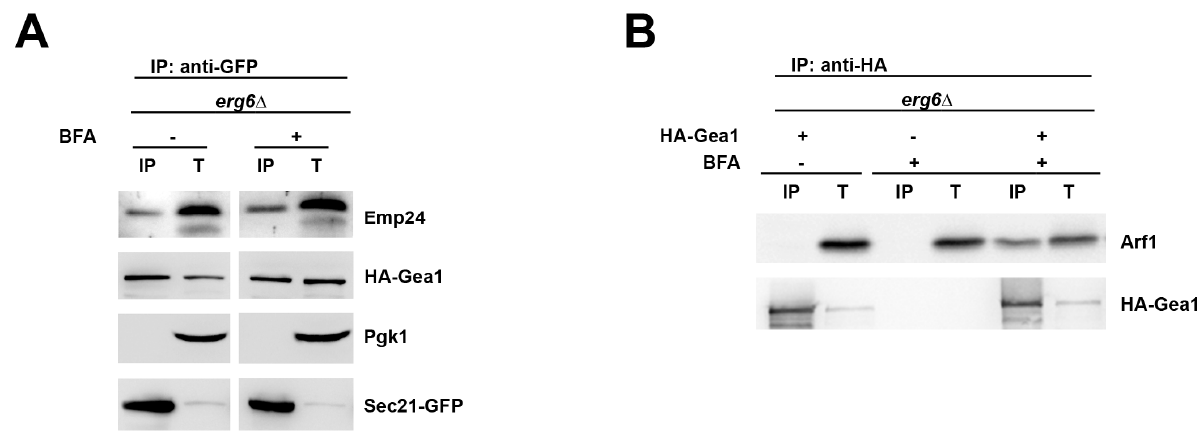
Figure 5. The p24 complex can interact with COPI independently of Arf1 activation. ( A ) erg6 ∆ mutant cells expressing HA-Gea1 and the COPI coat subunit Sec21-GFP were incubated with or without 100 µg/mL BFA (Brefeldin A) for 20 min. erg6 ∆ mutation was used to increase the plasma membrane permeability to BFA. Detergent-solubilized S13 fractions from these cells were subjected to native immunoprecipitation (IP) with anti-GFP antibody, followed by immunoblotting. Total (T) represents a fraction of the solubilized input material. ( B ) BFA treatment is effective because it traps Arf1 in complex with HA-Gea1. erg6 ∆ mutant cells expressing HA-Gea1 were incubated with or without BFA for 20 min. Detergent-solubilized S13 fractions from these cells were subjected to native immunoprecipitation (IP) with anti-HA antibody, followed by immunoblotting. Total (T) represents a fraction of the solubilized input material.